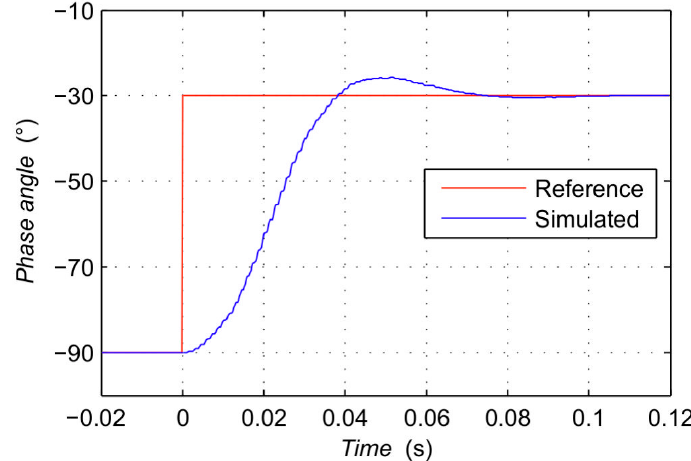
Figure 5. Voltage 7th harmonic phase angle response to step reference.